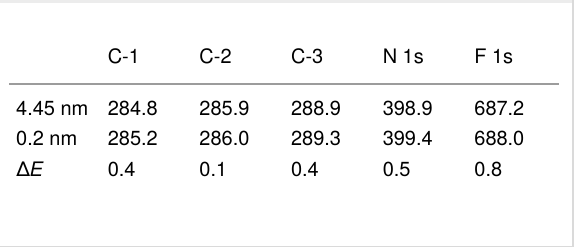
Table 1: Binding energy shifts of core level spectra of CoPcF 16 as a function of the film